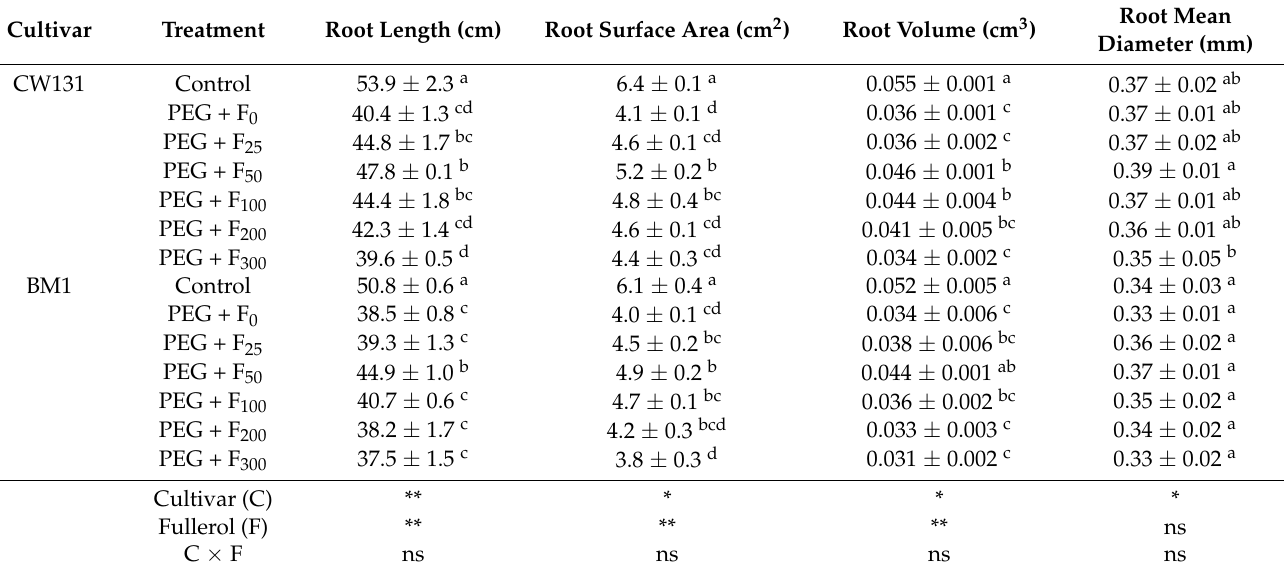
Table 2. Effect of different fullerol additions (concentrations range from 0 to 300 mg L − 1 ) on the root growth parameters of two winter cultivars (CW131 and BM1) under PEG (20% polyethylene glycol)